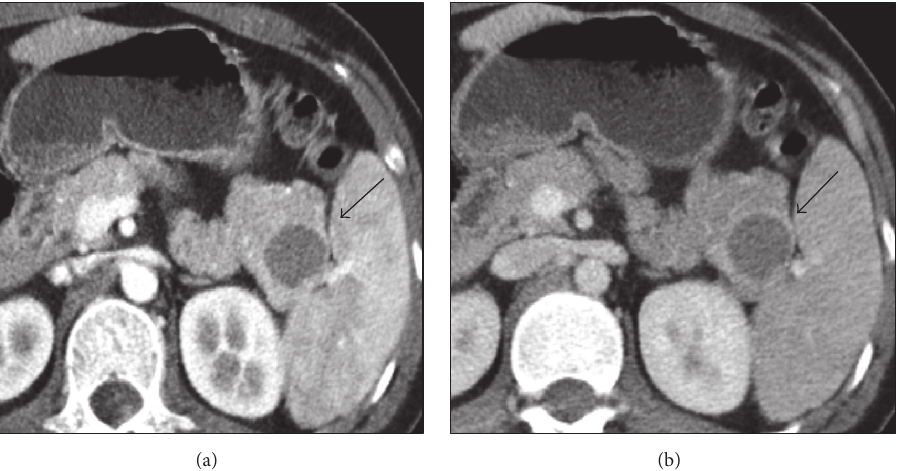
Figure 1: (a) Arterial and (b) portal-venous phase CT, confirming cystic lesion in pancreatic tail without soft-tissue component.